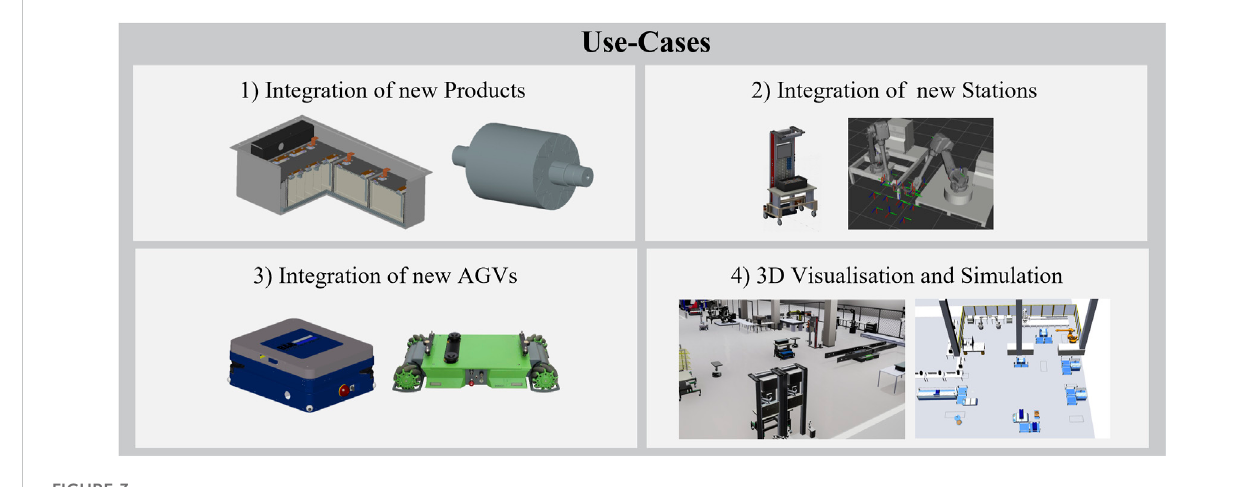
FIGURE 3 Introduction of the four selected industrial use